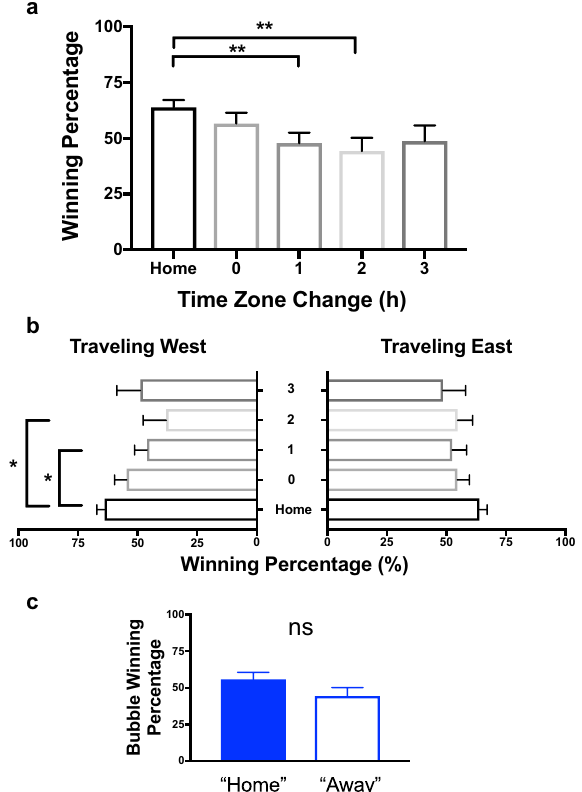
Figure 1. Team winning percentage when playing at home, away (by time zone change), and in the restart bubble with no travel. Brackets with asterisks denote significant differences at the end of each line; * denotes p < 0.029, **denotes p < 0.01. NS denotes not significant. Error bars are standard error of the